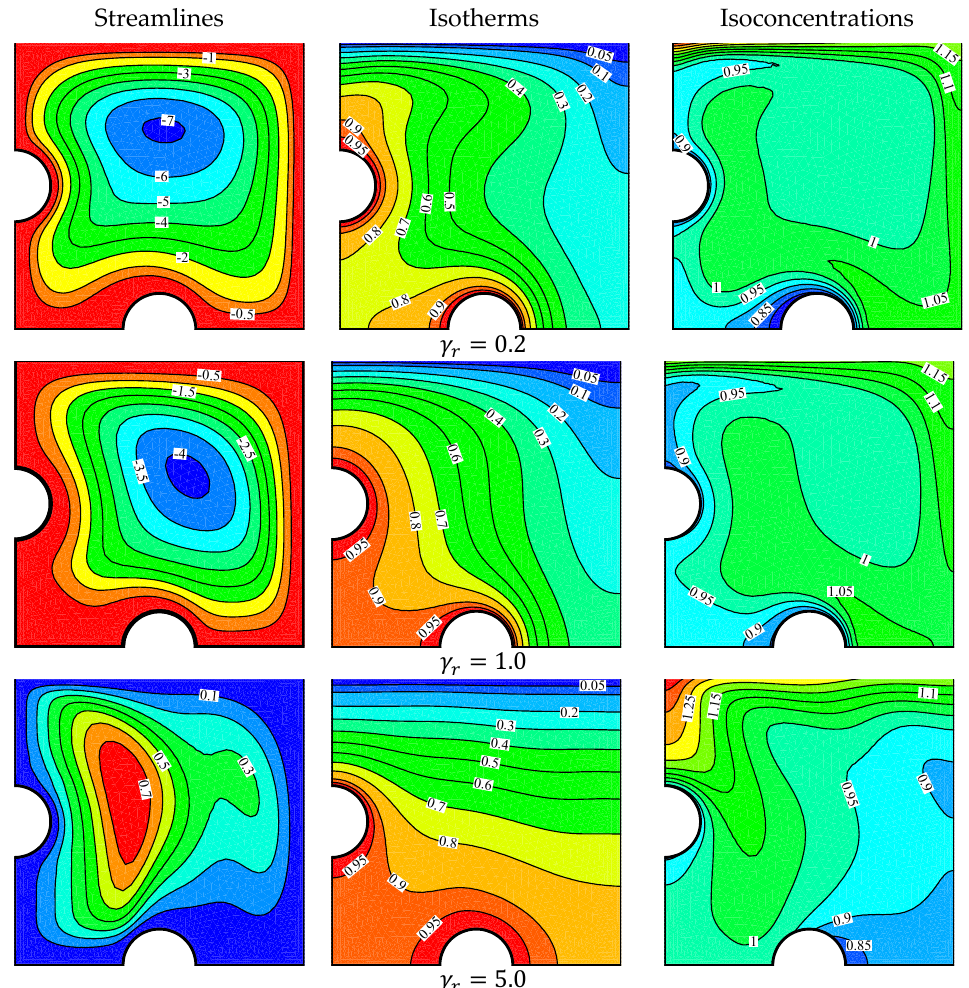
Figure 6. Nanoparticles isoconcentrations, streamlines and temperature field at different γ r for 𝑀𝑛 (cid:3033) = 1000 , 𝑅𝑎 = 10 (cid:2873) , 𝑁𝑏 = 𝑁𝑡 = 𝑁𝑟 = 0.5 , 𝐻𝑎 = 20 , and 𝐿𝑒 = 10 .